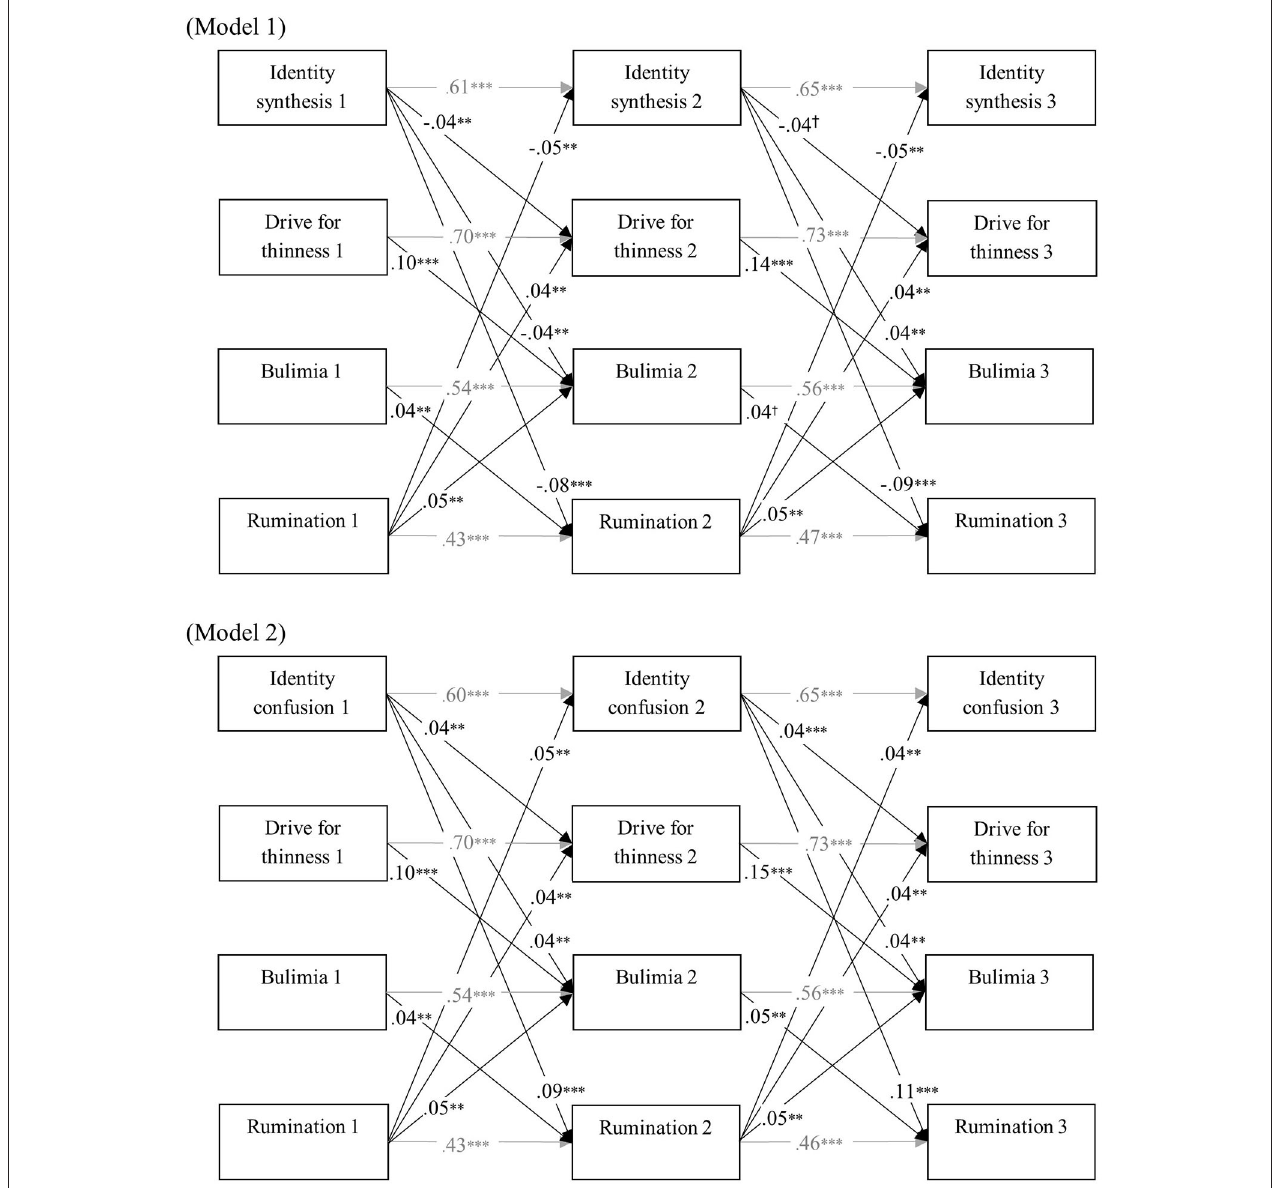
FIGURE 2 | Final cross-lagged models linking identity functioning, ED symptomatology, and rumination. All models were controlled for age and gender. Within-time associations, associations with age and gender, and insignificant cross-lagged paths were not shown for reasons of clarity. All path coefficients are standardized. † p < 0.05, ** p < 0.01, *** p <